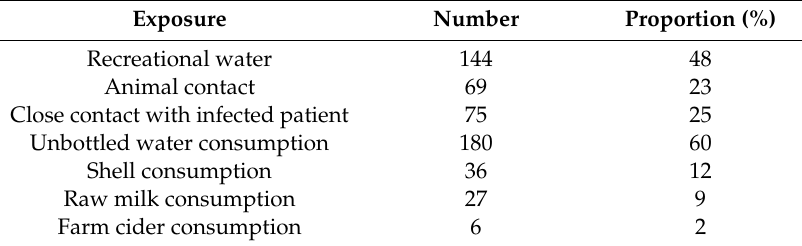
Table 5. Potential exposure to risk factors in notified